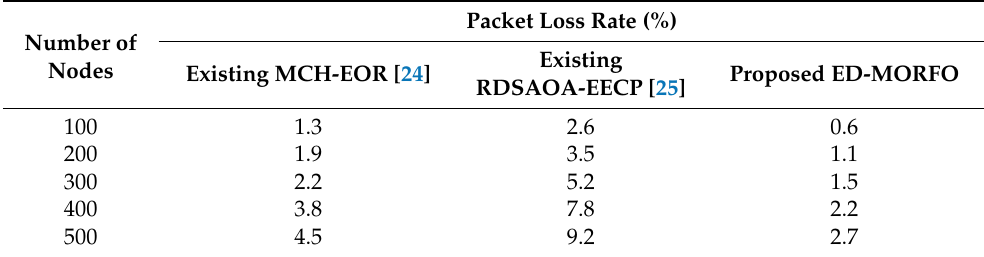
Table 9. Performances of computational complexity.